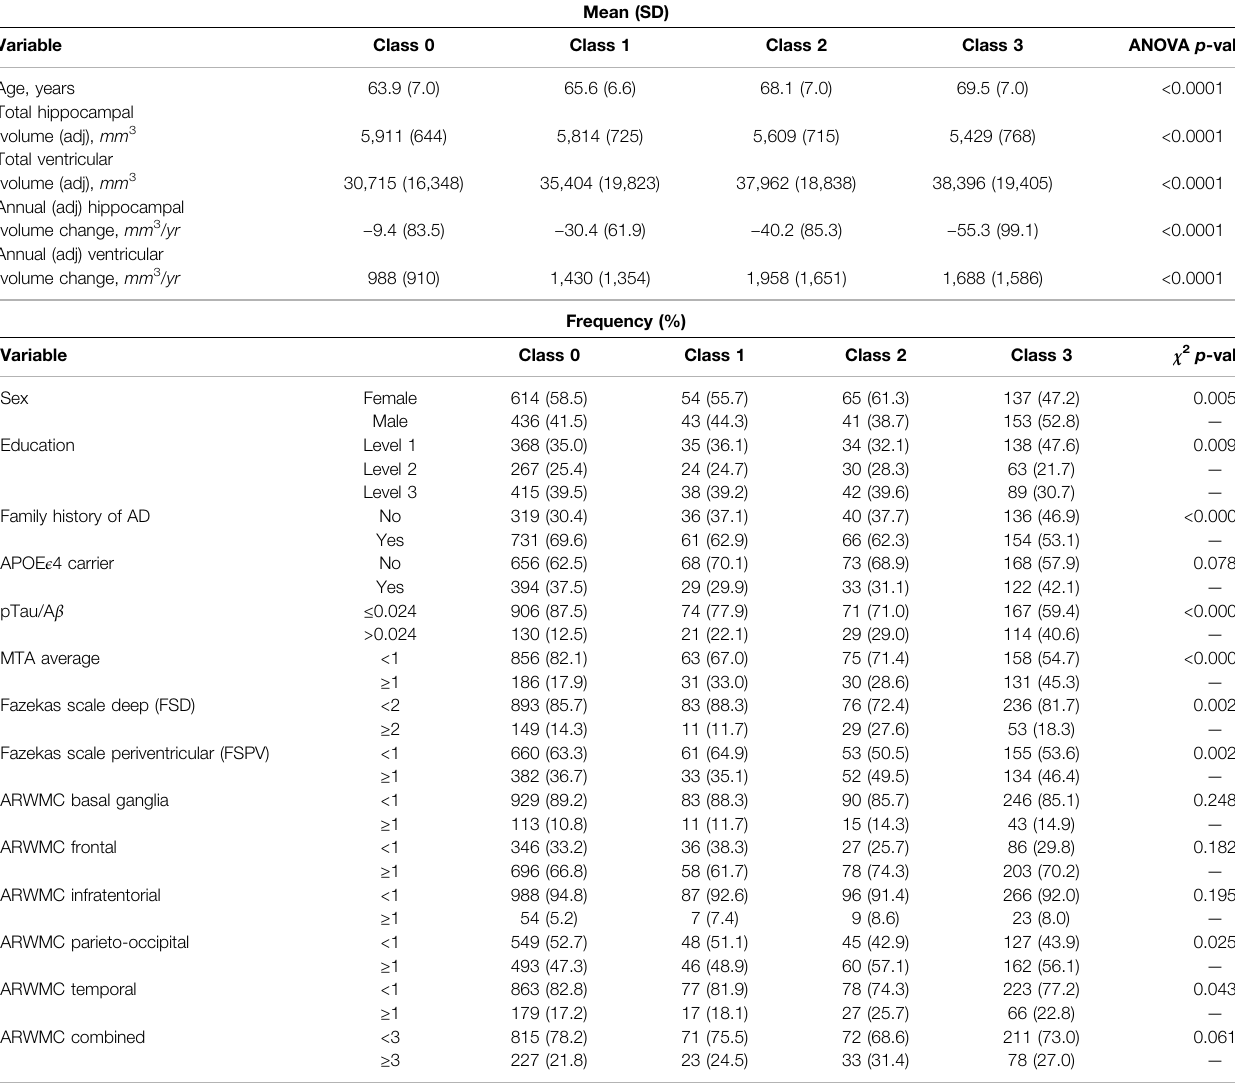
TABLE 3 | Characterisation of the baseline and change variables by latent phenotype